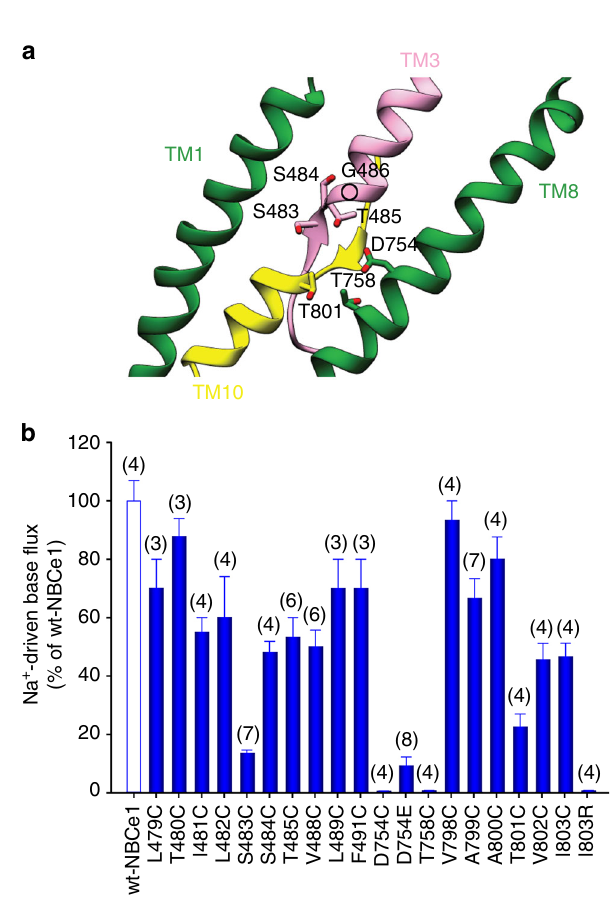
Fig. 3 NBCe1 ion coordination site. a The ion coordination site modeled from the cryoEM densities. Residues important for ion coordination are shown. The circle represents the position of Gly486 in the NBCe1 model. b Na + -driven base transport functional mutational analysis of the amino-acid residues located in the ion coordination region. The mean ± s.e.m. is depicted. The number of experiments is shown in parentheses. The residues in this region that are important for ion coordination shown in a and those not important for ion coordination (e.g., Leu479, Thr480, Leu489, Phe491, Val798 etc.) are shown for comparative